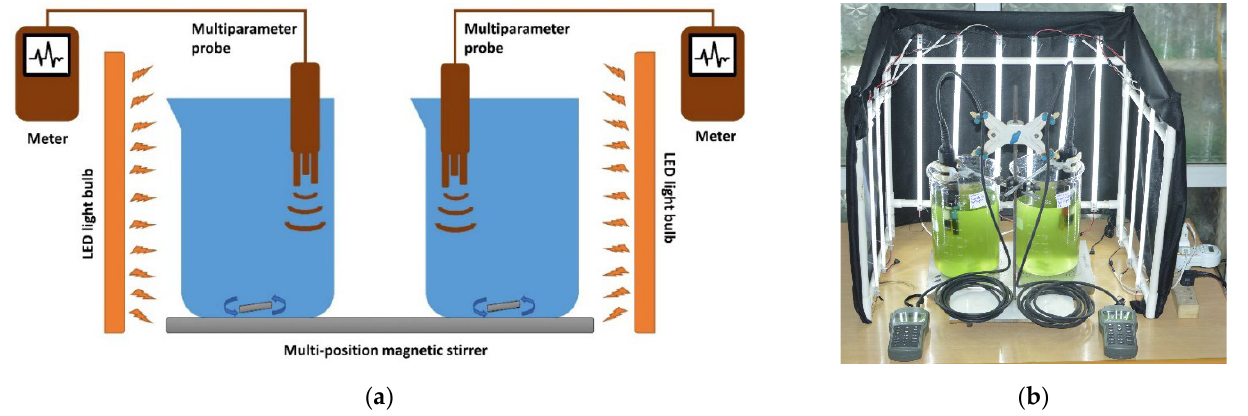
Figure 1. General illustration of the experimental setup ( a ) and picture of the real setup ( b ). Table 2. Operational characteristics of different experiments.